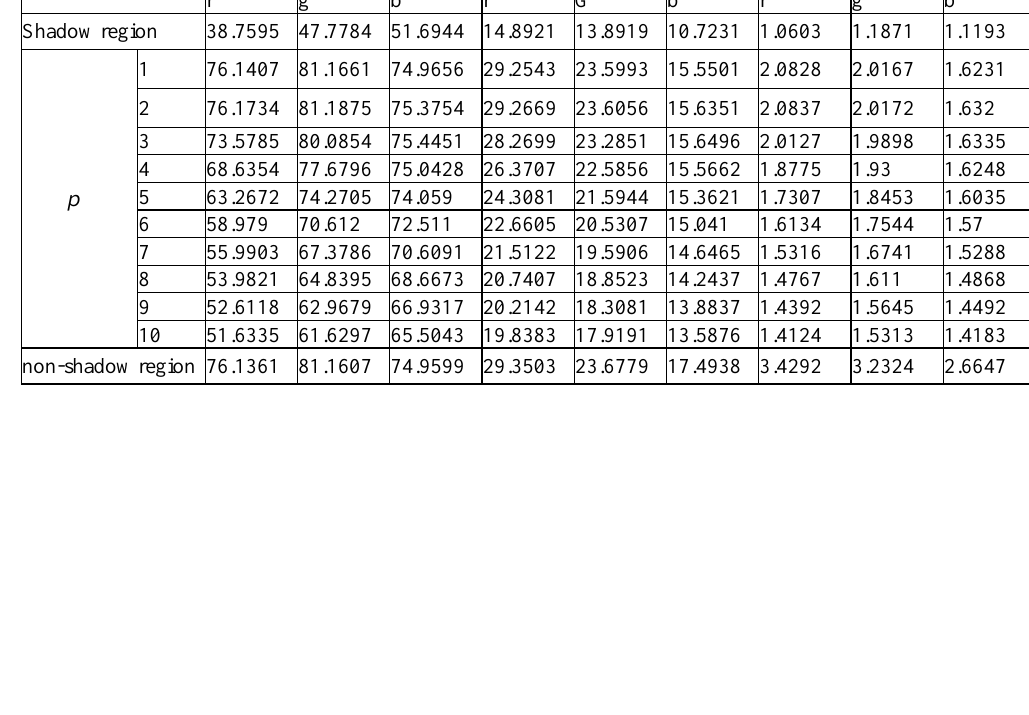
Table 1. The brightness, contrast and average gradients of the true color aerial image before and after shadow removal brightness contrast average